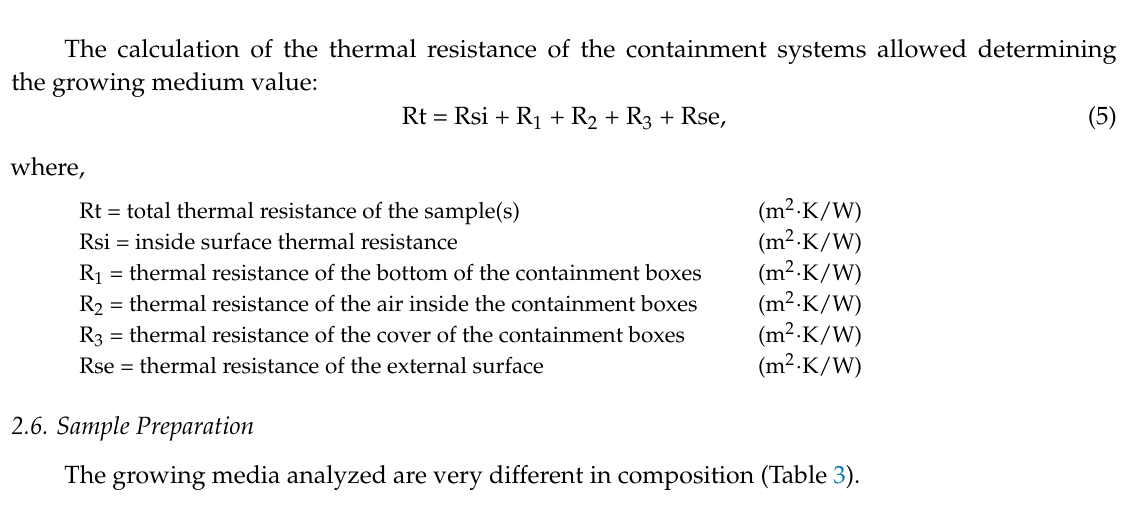
Table 3. Description of the growing media extensive and intensive